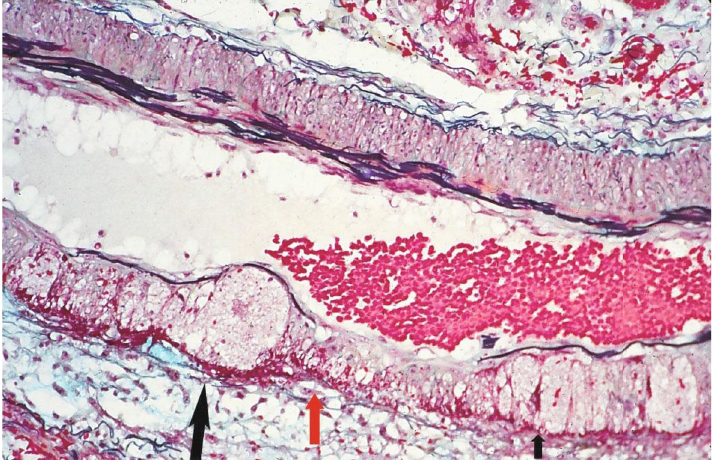
Figure 6: Segmental arterial mediolysis injurious phase. The large black arrow points to a focus of transmural mediolysis with foamy contents that has caused a bulging of the arterial wall bordered inwardly by an intact internal elastica and outwardly by a linear deposit of fi brin. The bulge contents are alcian blue negative. The small black arrow points to a similarly bulging media, and the red arrow to a beginning gap created by the incipient medial loss of the watery mediolytic contents thru an intima depleted of an internal elastica. Movat stain × 100 (adapted with permission from the American Journal of Surgical Pathology 13(7) copyright l989, Lippincott, Williams and